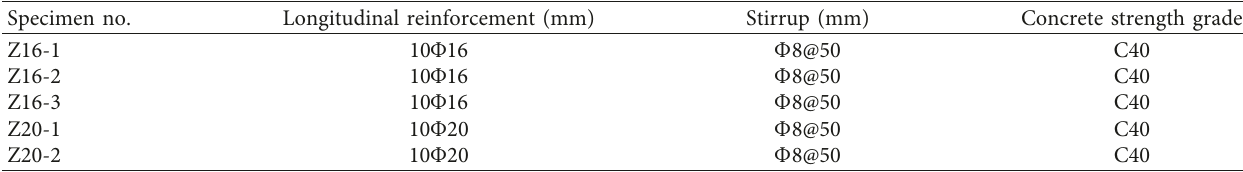
Table 1: Test specimen numbers and design parameters.